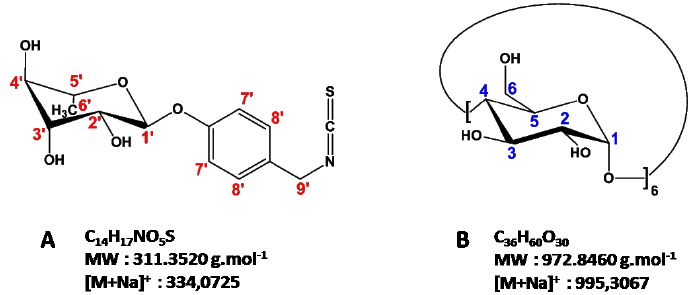
α -cyclodextrin ( α